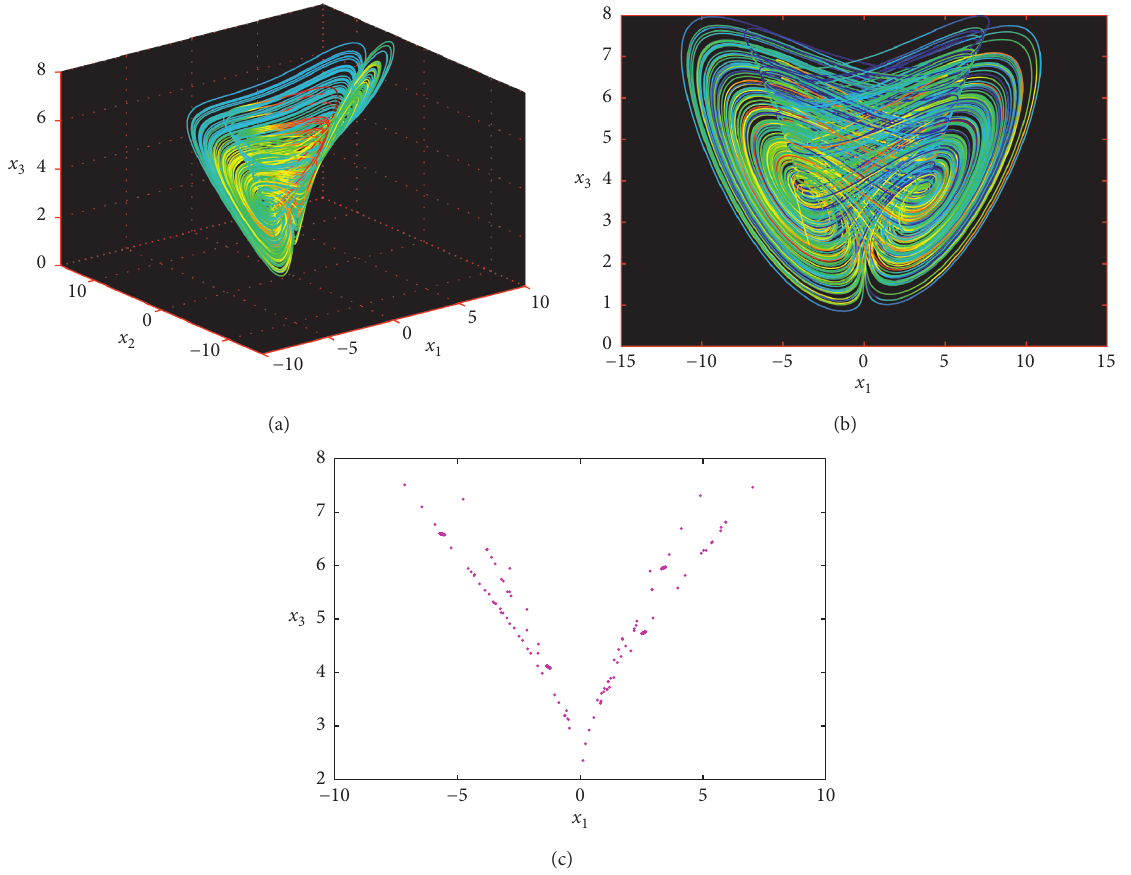
Figure 1: (a) x 1 - x 2 - x 3 phase portrait; (b) x 1 - x 3 phase portrait; (c) Poincare mapping.